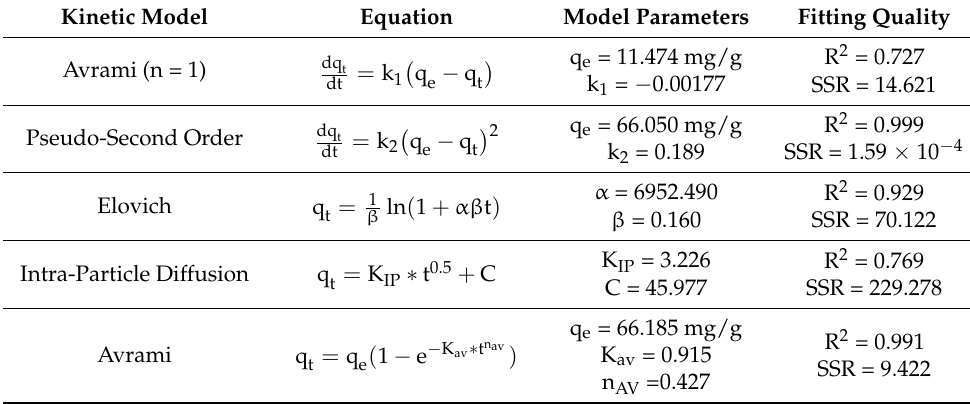
Table 3. Summary of the parameters for each kinetic model